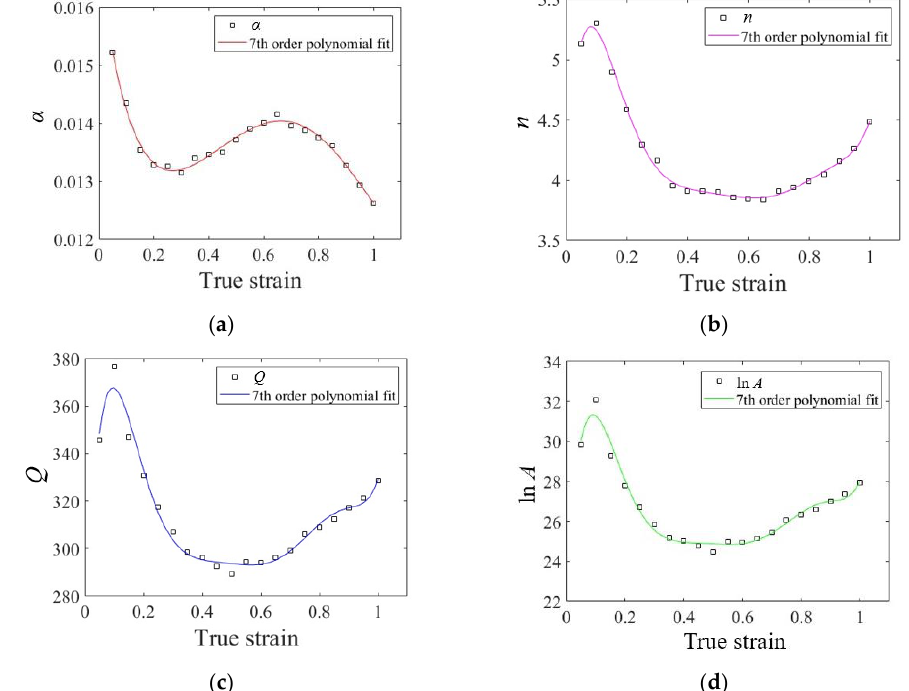
Figure 6. The relationship between the material constant value – true strains ( a ) α , ( b ) n , ( c ) Q , and ( d ) ln A . Table 3. 7th-order polynomial coefficients of material constants α, n , Q , ln A .